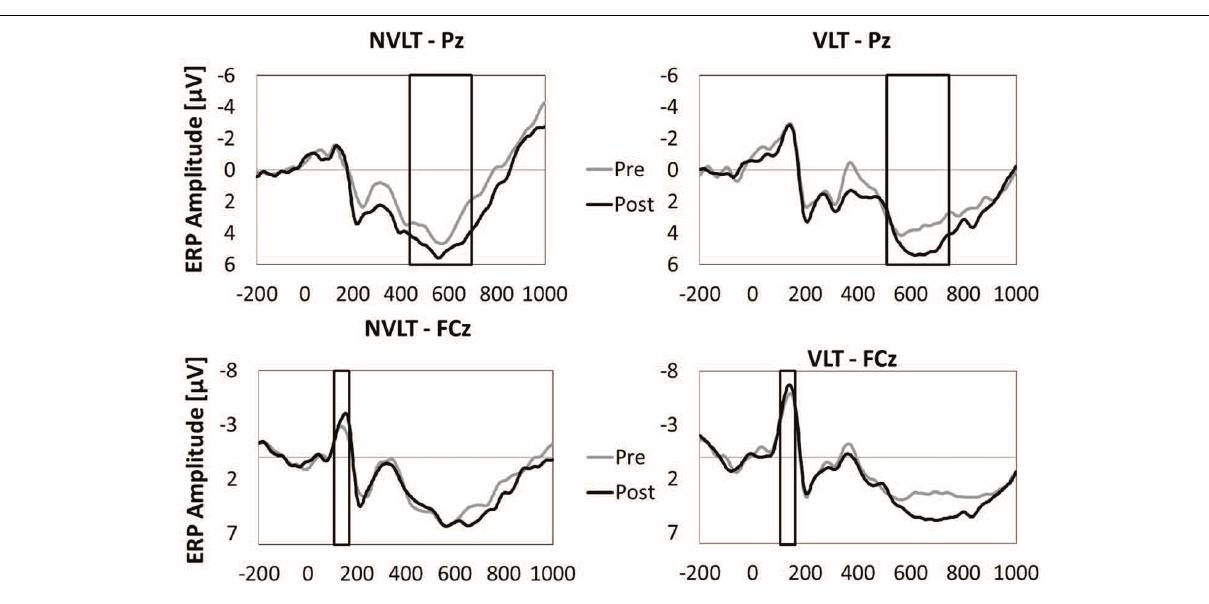
The healthy group showed a tendency for a higher P3 amplitude in the post-compared to the pre-measurement during stimulus processing of the non-verbal task [ t (9) = 1.91, p = 0.08, d = 1.21, p bootstrapping = 0.078; see Figure 5 ]. When comparing the N1 amplitude between pre- and post-test, no differences were found [ t (9) = 0.82, n.s., d = 0.51, p bootstrapping = 0.36]. In the verbal task, there were neither pre–post differences in P3